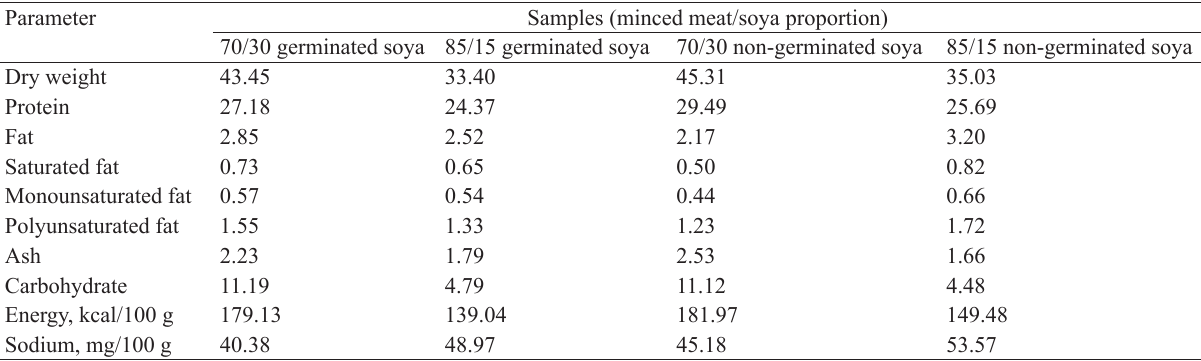
Table 2 Nutritional composition of meatball samples with soya flour Parameter Samples (minced meat/soya proportion)